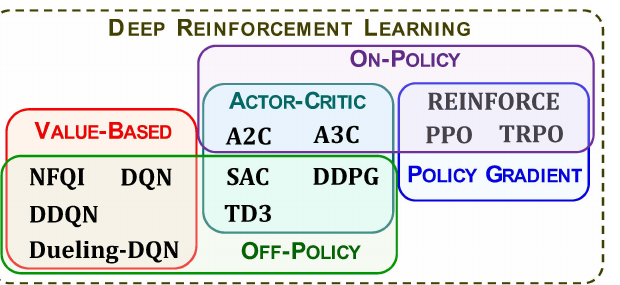
Figure 2. Taxonomy of Deep Reinforcement Learning. Classification of all deep reinforcement learning methods that are described in this article are shown. Section 3.2 provides a description of each class. (See also